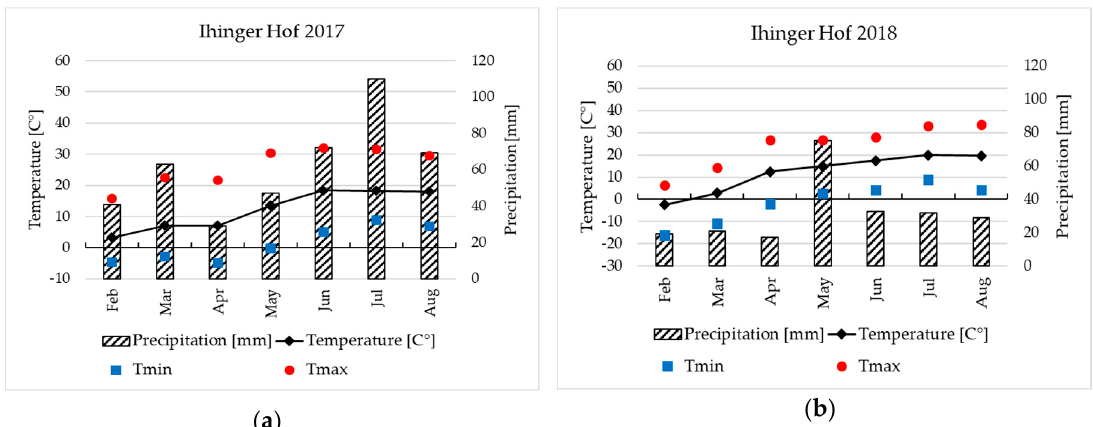
Figure 2. Average temperature (°C, connected points), mean monthly maximum (T max , °C, red points) and minimum temperature (T min , °C, blue points), and accumulated monthly precipitation (mm, bars) during the field experiments in ( a ) 2017 and ( b ) 2018.